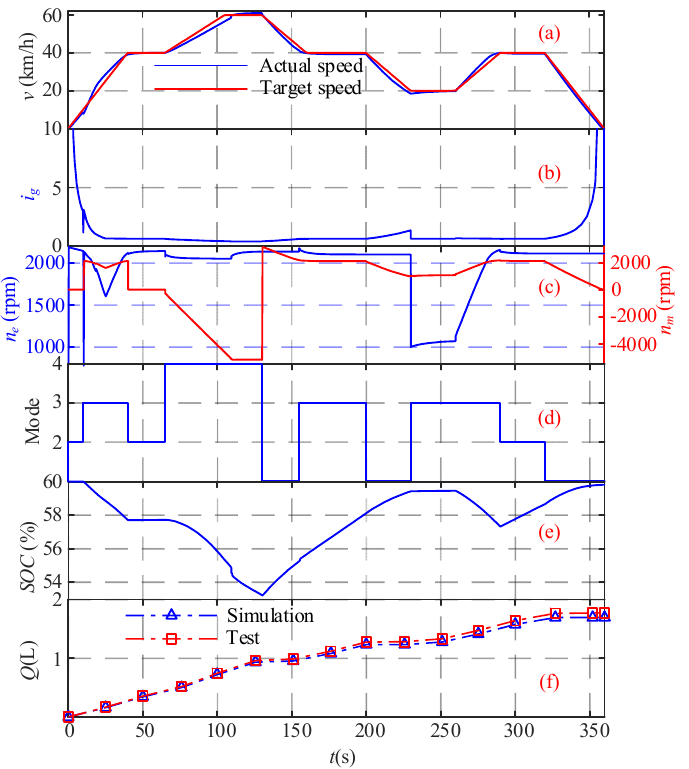
Figure 20. Results of the transport operation: ( a ) tractor speed, ( b ) transmission ratio, ( c ) engine and motor speed ( d ) driving mode, ( e ) SOC curve, ( f ) simulation and test fuel consumption.